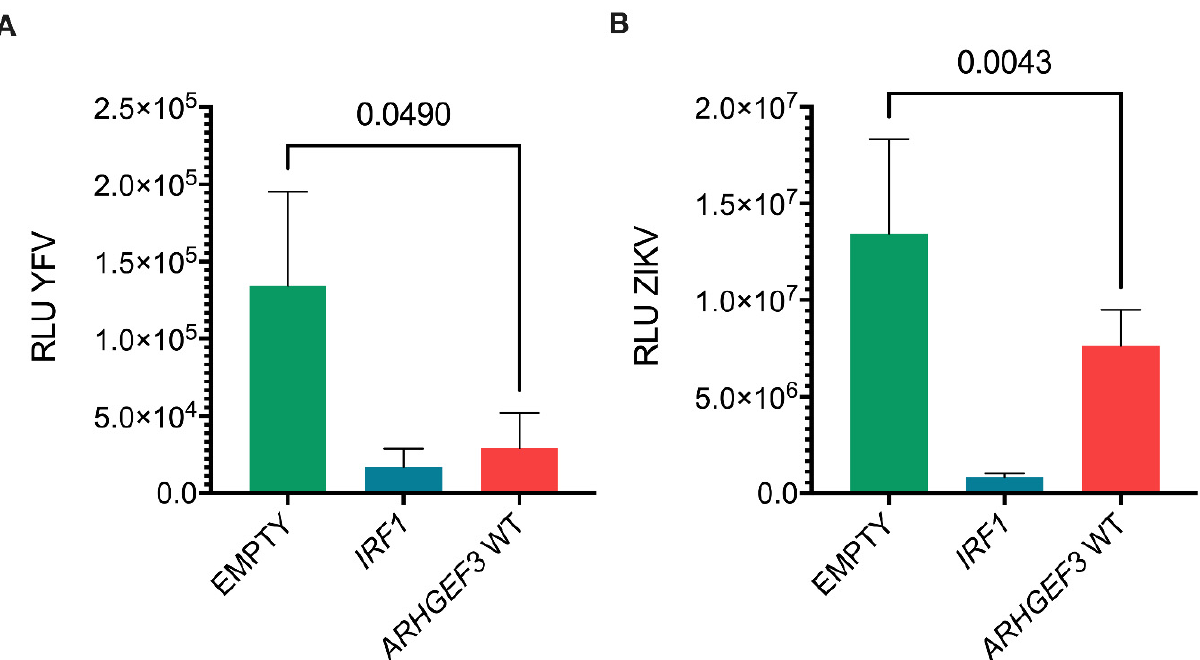
Figure 5. Antiviral activity of ARHGEF3 against flaviviruses. RLU activity in Huh7 cells stably expressing ARHGEF3/XPLN or IRF1 following infection with recombinant luciferase-expressing YFV ( A ) and ZIKV ( B ) as measured at 48 hpi and 72 hpi, respectively. Values from 3 technical replicates for YFV and 9 technical replicates for ZIKV were used and variation is shown as standard deviation of the mean alongside p values for Student’s T test between EMPTY and ARHGEF3 WT results.